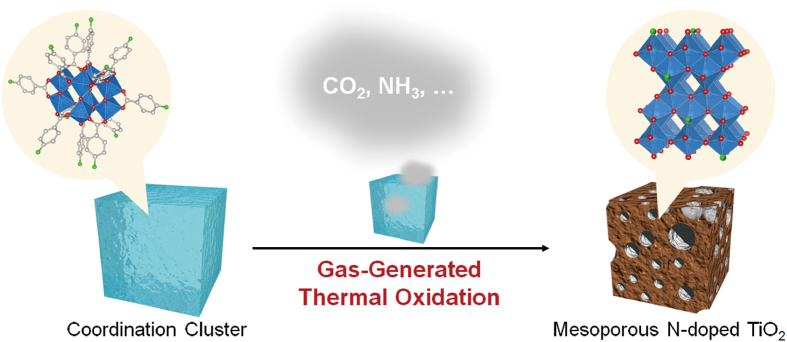
Schematic illustration of gas-generated thermal oxidation of a coordination cluster.